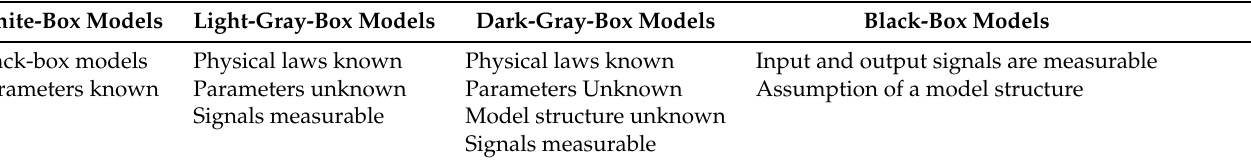
Table 1. Different kinds of mathematical process models.